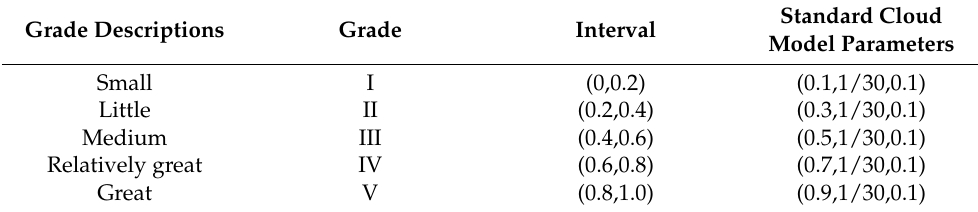
Table 2. Standard cloud